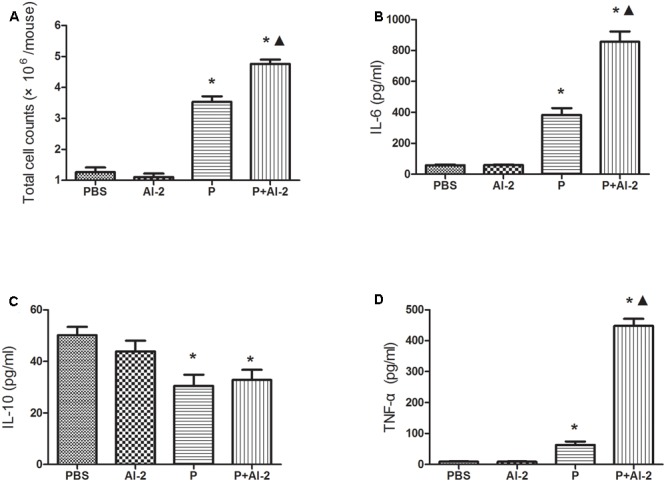
Effects of AI-2 on BALF cytokine levels. BALF was collected at 24 h post infection. Each sample was analyzed by an ELISA kit. The mice were infected with PBS, AI-2, P. aeruginosa PAO1 (P) and AI-2 + P. aeruginosa PAO1 (P+AI-2), respectively. Total cells (A), IL-6 (B), IL-10 (C) and TNF-α (D) levels present in the BALF of the respective treatment groups are shown. Triangles denote a statistically significant difference from the PAO1 group (P < 0.05), asterisks denote a statistically significant difference from the PBS group (P < 0.05).